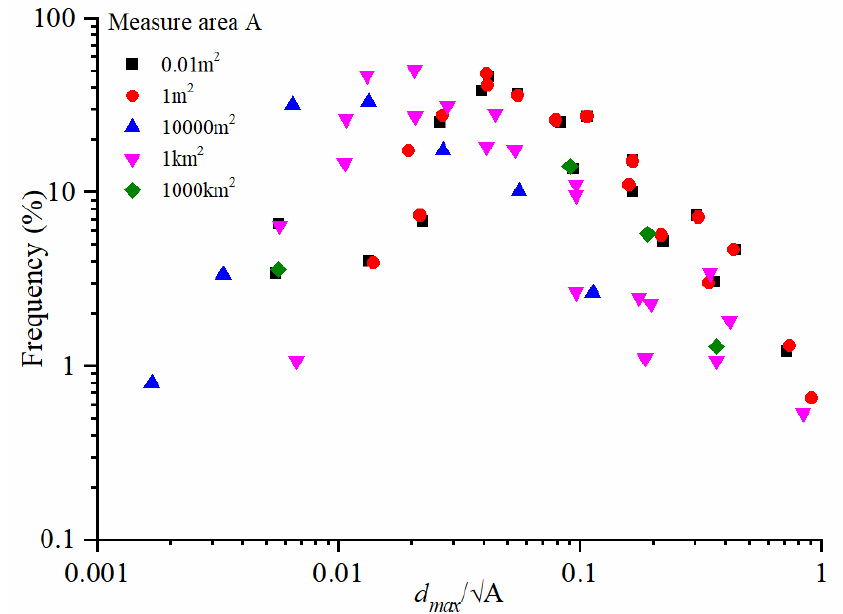
Figure 4. Particle-size-distribution characteristics of SRM after normalization.